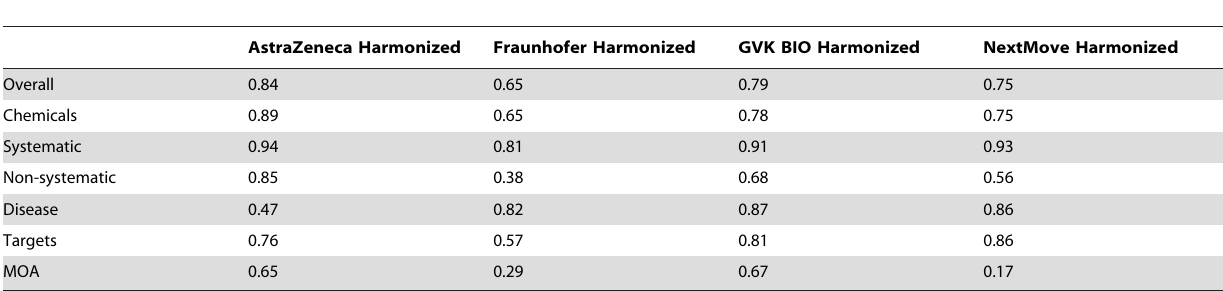
Table 6. Inter-annotator agreement (F-score) between the harmonized set and the annotator groups for the main entity